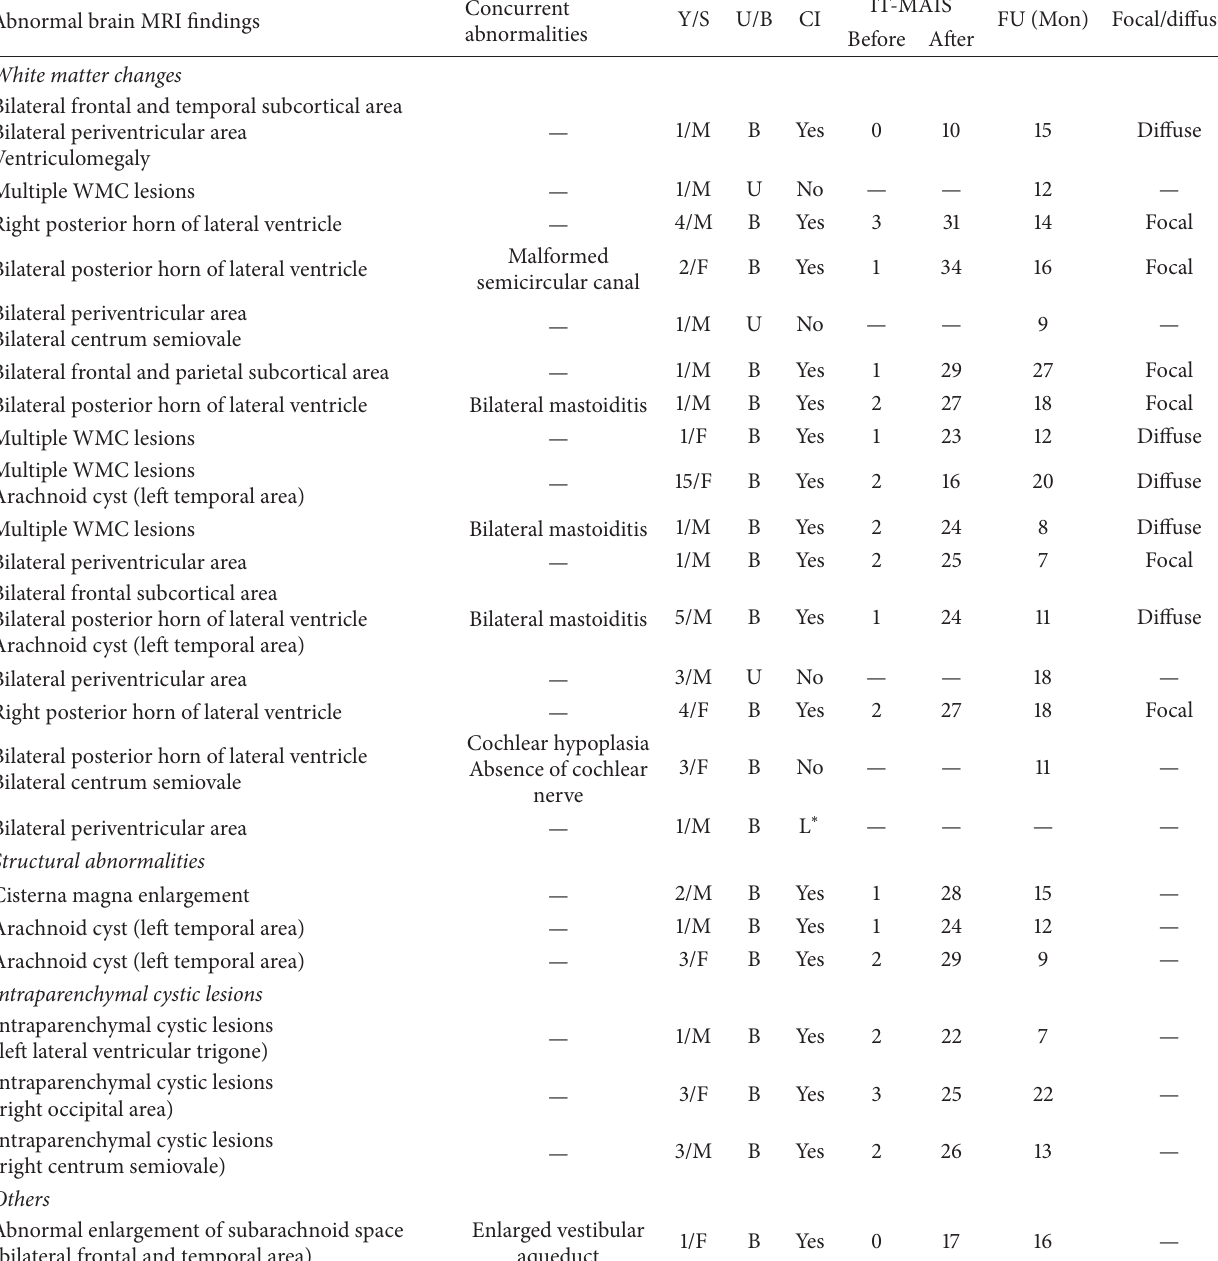
Table 1: Follow-up of 23 SNHL patients with brain abnormalities after cochlear